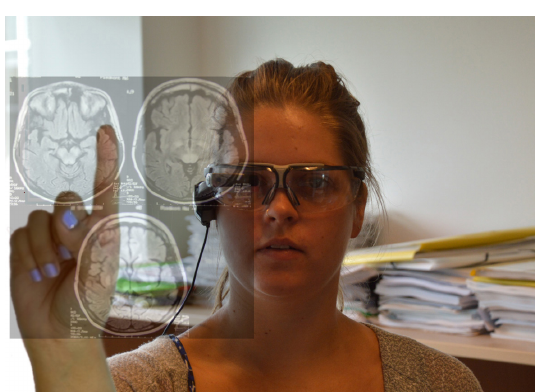
Figure 10. An illustration of our prototype where a fictive nurse is looking at the electronic patient records through a Vuzix M100 smart glass device and interacts with CT Scans using hand